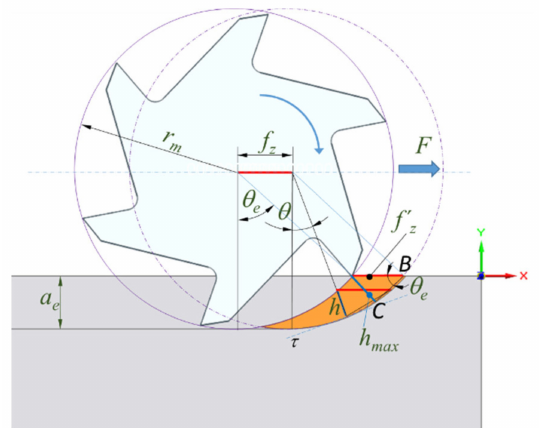
Figure 4. Engagement angle and chip thickness in lineal path.